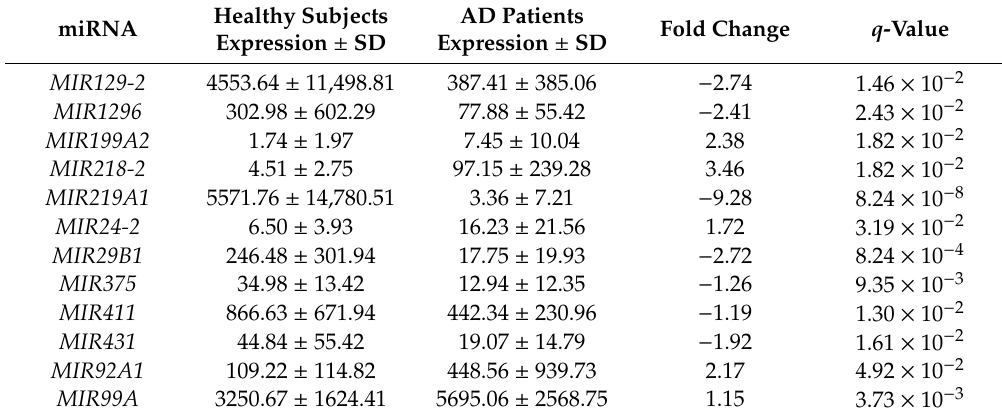
Table 1. miRNAs that were di ff erentially expressed in healthy subjects and AD patients, with fold change and q -value. Healthy Subjects AD Patients miRNA Expression ± SD Expression ±